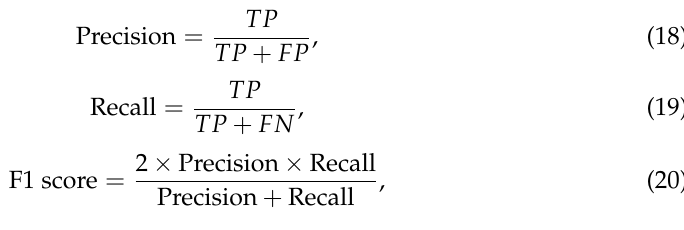
score; Figure S2: The correlation of different synergy score on dataset; Table S1: The division of positive samples for DDI task and the number of each DDI type; Table S2: The hyperparameters settings of comparing